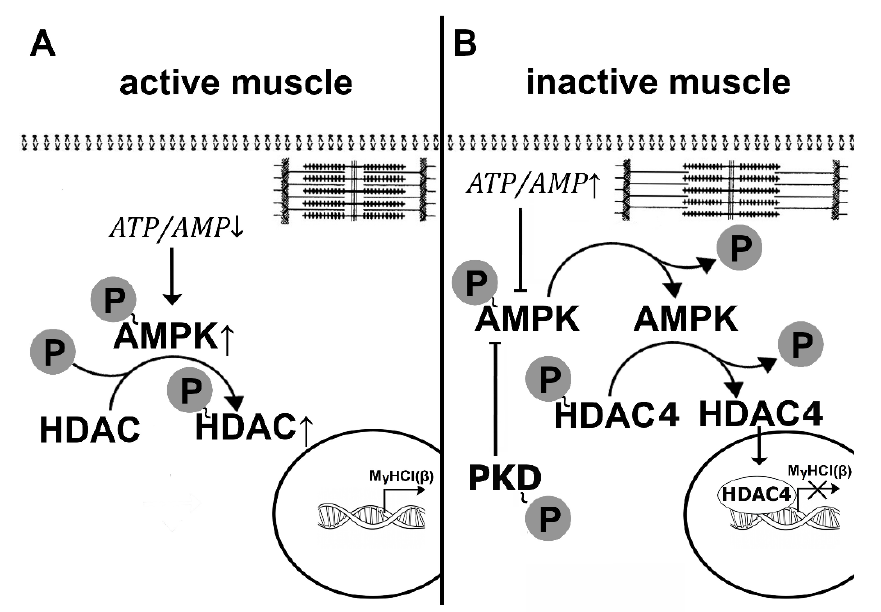
Figure 7. AMPK (Thr172) dephosphorylation as a factor reducing the expression of the slow isoform of MyHC. In active muscle ( A ), phosphorylated (Thr172) and activated AMPK phosphorylates histone deacetylase 4 (HDAC4), preventing its nuclear translocation and thus providing an unhindered expression of the slow MyHC. In the first 24 h of unloading ( B ), changes in the balance of ATP / ADP / AMP and high protein kinase D activity can lead to the dephosphorylation of AMPK, which can no longer prevent HDAC4 nuclear translocation and its interaction with SIRT1, MEF2D, and histone H3. In this case, the expression of the slow isoform of the MyHC gene is inhibited.